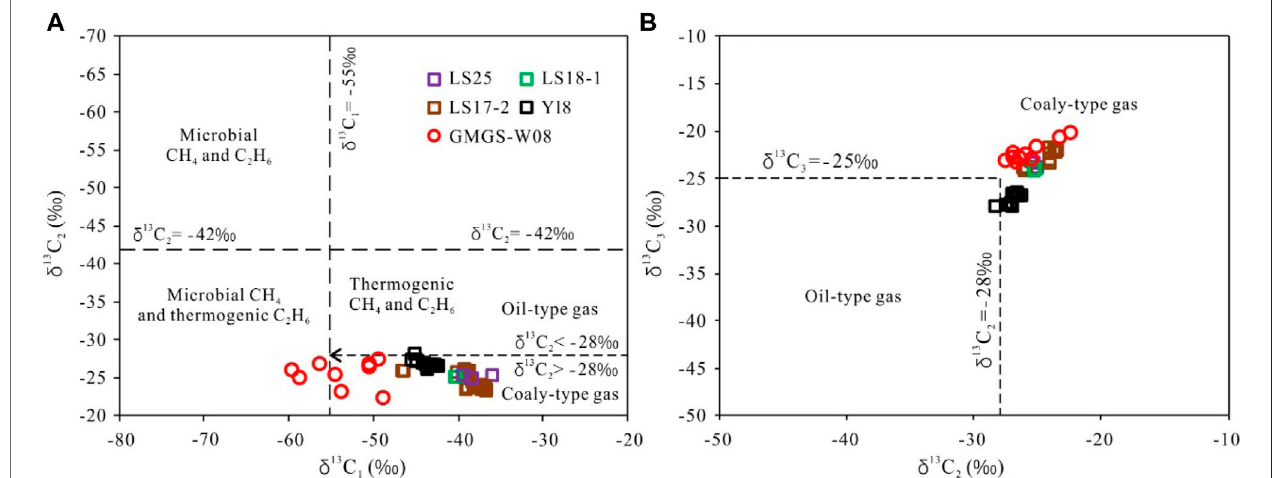
FIGURE4|(A) Geneticdiagramof δ 13 C 1 versus δ 13 C 2 showingathermogenicandmicrobialmixedgasofthenaturalgashydrate(modi fi edfromMilkov,2005). (B) Genetic diagram of δ 13 C 2 versus δ 13 C 3 (Modi fi ed from Liu S. Y. et al., 2019) showing a coal-type gas of the natural gas hydrate. All data were collected from the LS25, LS17-2, LS18-1, YL18, and GMGS5-W08 gas fi elds ( Table 2 ).